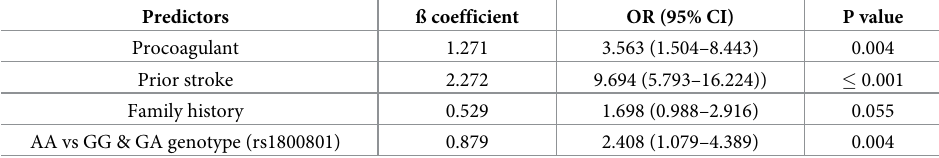
Identification of patients at risk for recurrent stroke is critical because approximately one- quarter of all strokes represent with recurrence and purport poor outcomes. Additional cere- brovascular ischemic events or systemic vascular ischemic events increase the risk for morbid- ity and mortality [1]. Thus, secondary prevention in patients who recently experienced a cerebrovascular event is critical and warrants investigation of clinical and non-clinical risk fac- tors associated with stroke recurrence. Table 3. Predictors of recurrent stroke within first year after first stroke.